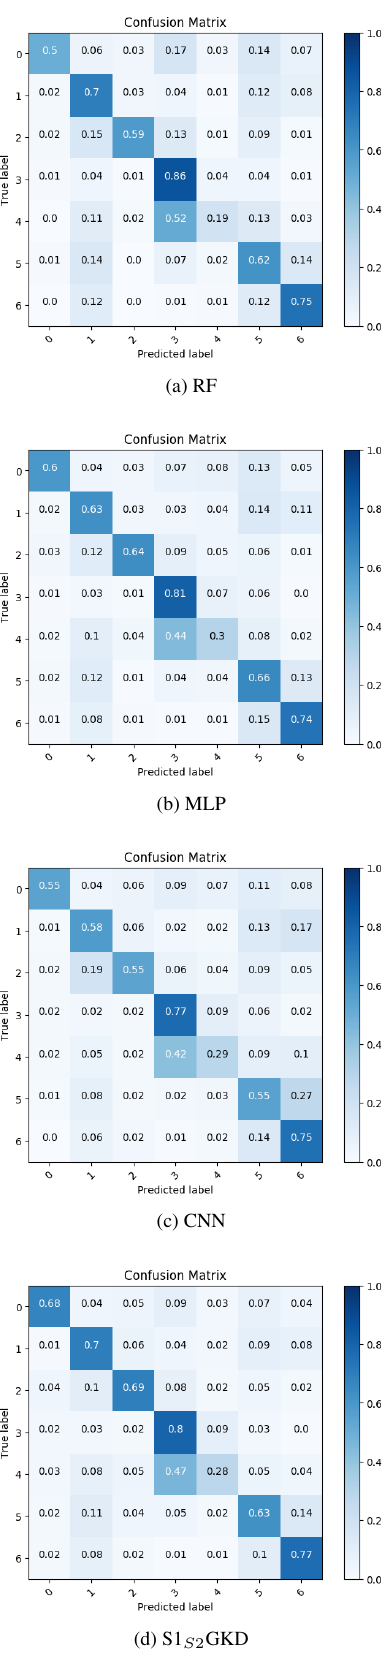
Figure 3. Confusion Matrices of the land cover classification produced by (a) RF, (b) MLP, (c) CNN and (d) S1 S 2 GKD on the Dordogne study